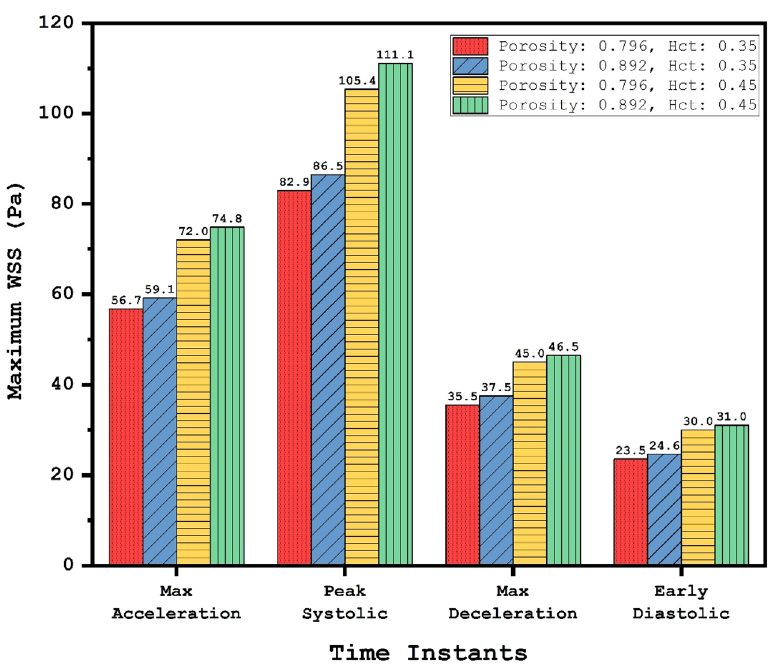
Figure 10. Effects of coiling (porosity) and patient sexuality (HCT) on the maximum WSS in different time